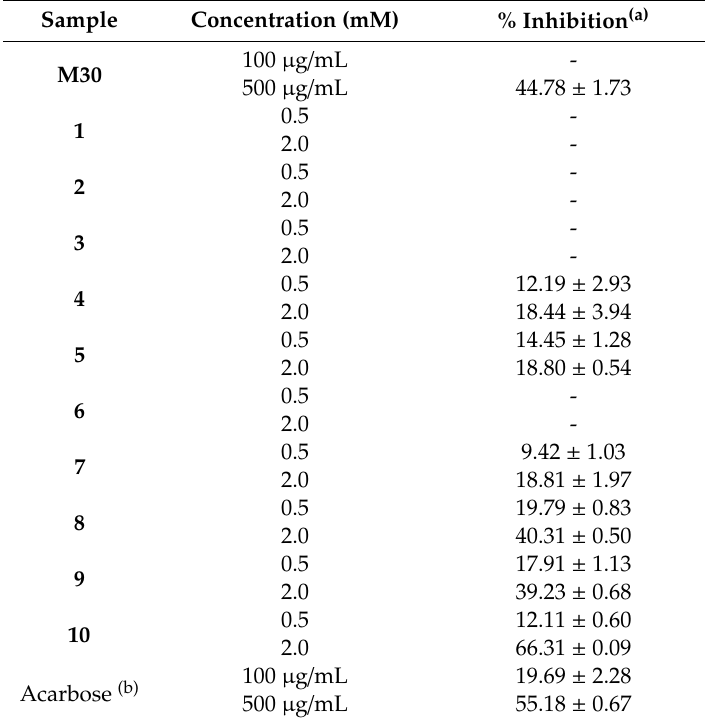
Table 2. α -Glucosidase inhibitory activity of compounds 1 – 10